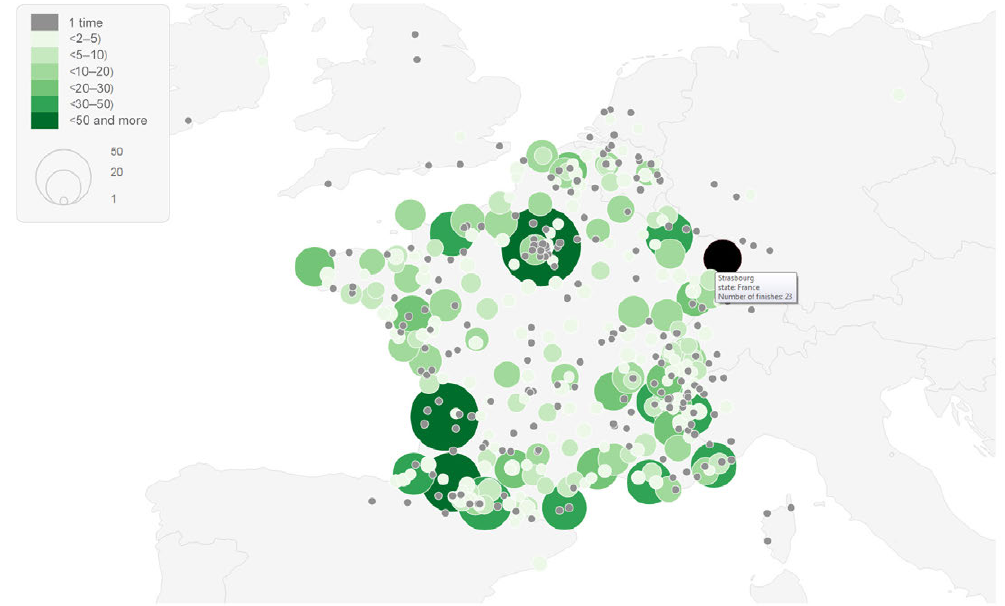
Fig. 4. An identification of stage finish places using an interactive map in the TopoJSON format (Interactive versions is available at